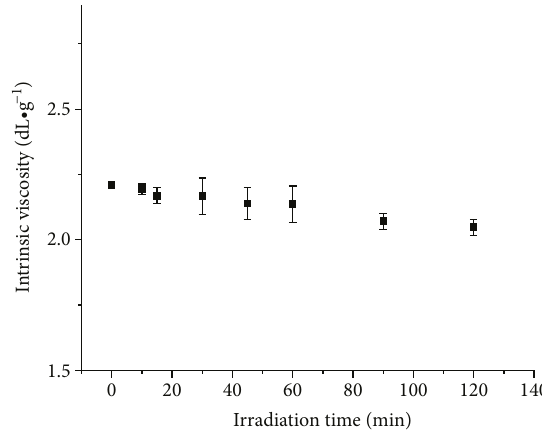
Figure 5: E ff ect of irradiation on GAP degradation. Each point represents an average value obtained in triplicate.